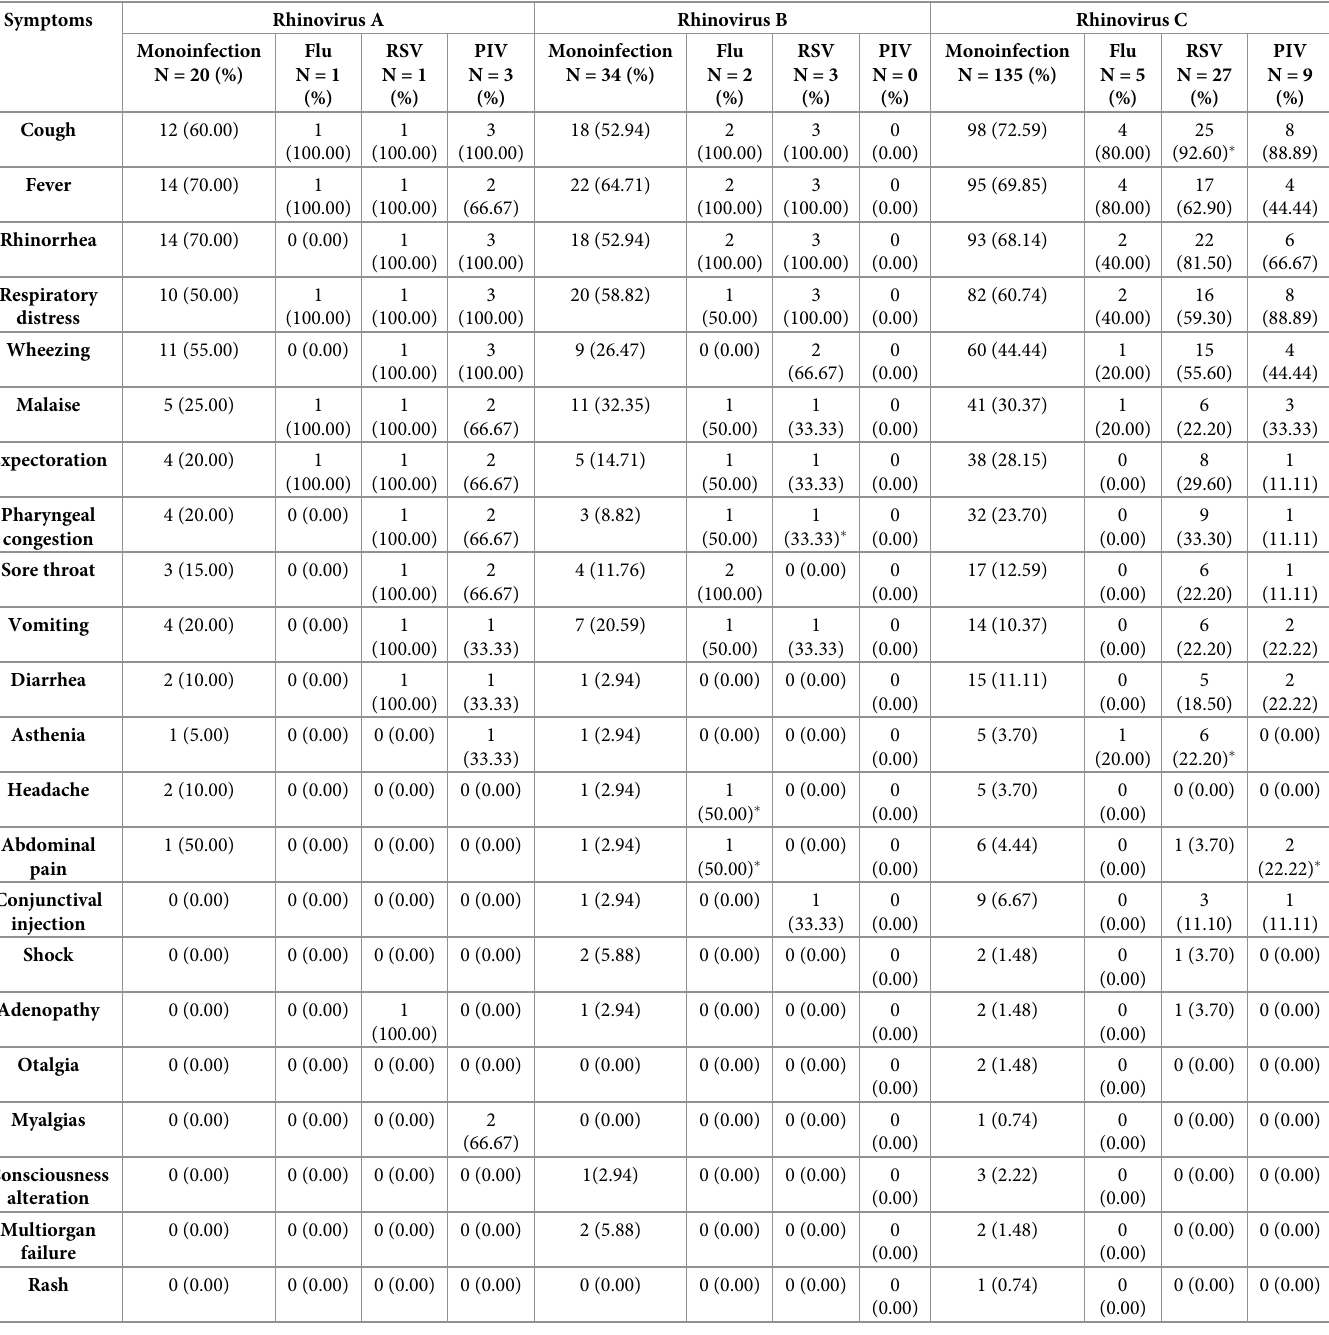
Table 4. Clinical characteristics of pediatric patients with rhinovirus infections and